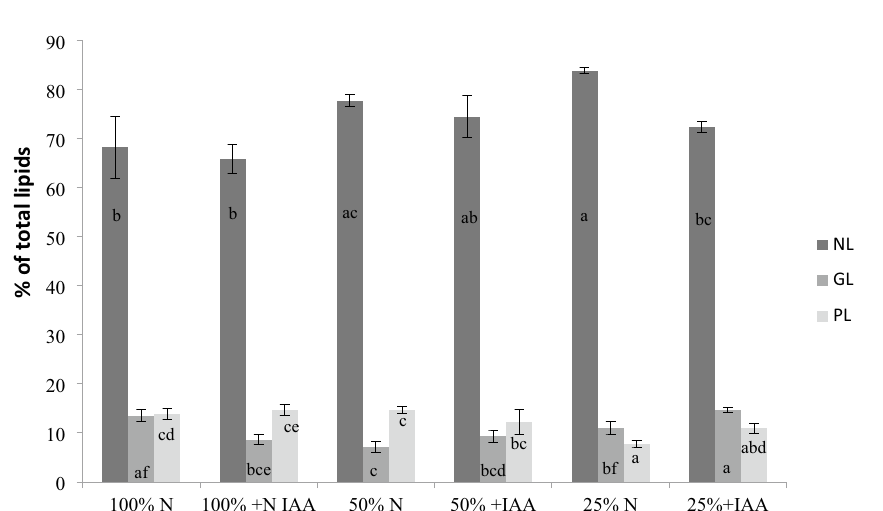
Figure 4. The influence of culture conditions on lipid class composition in Eustigmatos calaminaris cells. NL, neutral lipids; GL, glycolipids; PL, phospholipids. Data are expressed as means (± SD), n = 9. Means followed by the same letter are not significantly different; Tukey HSD test, p <